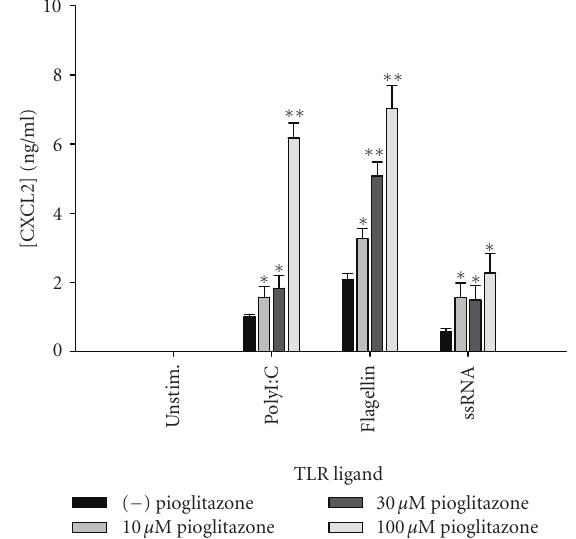
Figure 14: Pioglitazone enhances CXCL2 release by astrocytes following TLR ligand exposure. Primary astrocytes were plated at 1 × 10 5 cells/well in 96-well plates and incubated overnight. The following day, cells were pretreated for 1hour with the indicated concentrations of pioglitazone prior to the addition of polyI:C, flagellin, or ssRNA. Cell-conditioned supernatants were collected at 24hours following TLR ligand exposure, whereupon CXCL2 levels were determined by ELISA. Significant di ff erences between astrocytes treated with TLR ligands alone versus TLR ligands + pioglitazone are noted with asterisks ( ∗ P < . 05; ∗∗ P < . 001). Results presented are representative of two independent